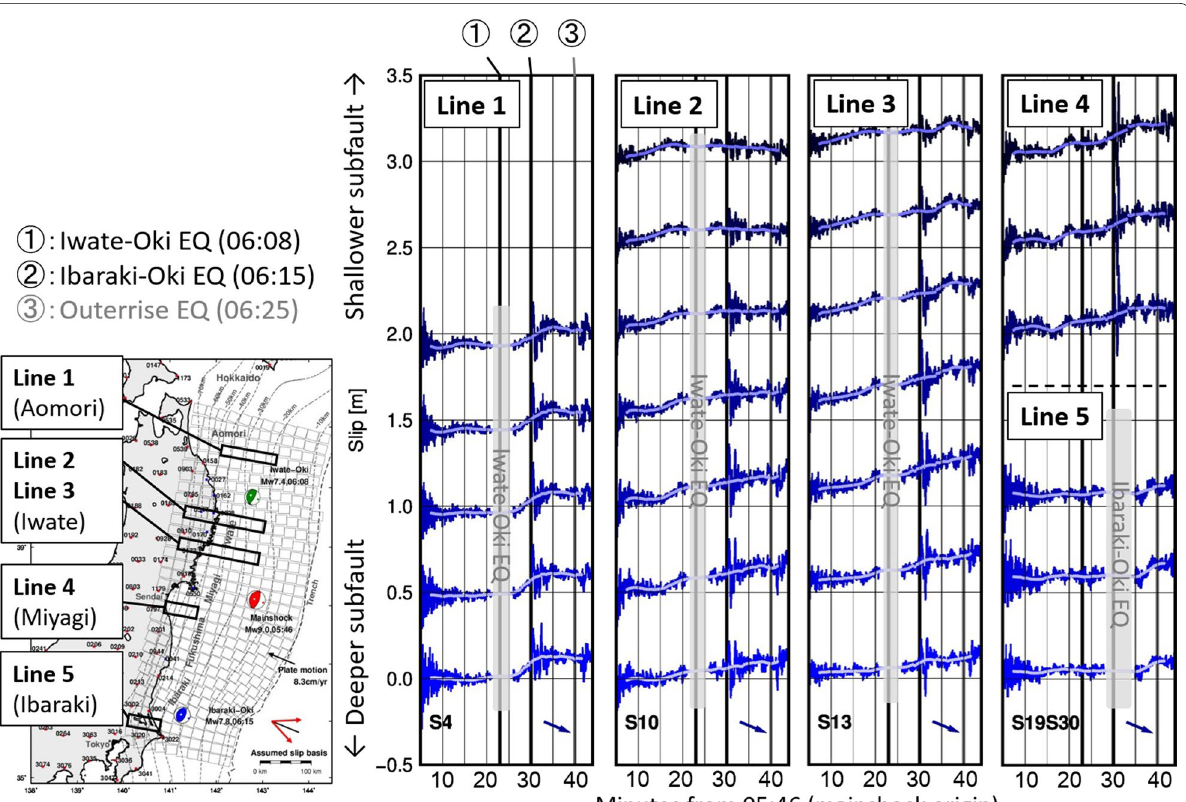
Fig. 3 Examples of the estimated early postseismic slip time series. Now, we show time series for the subfaults in the downdip region near Aomori (Line 1), near Iwate (Lines 2 and 3), near Miyagi (Line 4), and near Ibaraki (Line 5), as indicated by black rectangles in the left-side map. All figures display slip time series of 39 min after the mainshock (05:51–06:30 GPS Time) by setting its start as zero. The time series is shown for each subfault along dip direction with a step of 0.5 m. The top side is updip, while the bottom side is downdip. We show slip in the direction of reverse subduction, indicated by blue arrows inside the figures. Brighter color dots represent 5 min moving average of each time series, which is used for drawing Fig. 7. Black and gray vertical lines indicate the origin time of three large aftershocks. Please note that we removed the coseismic slip of the Iwate-Oki EQ and the Ibaraki-Oki EQ, so the time series look continuous without